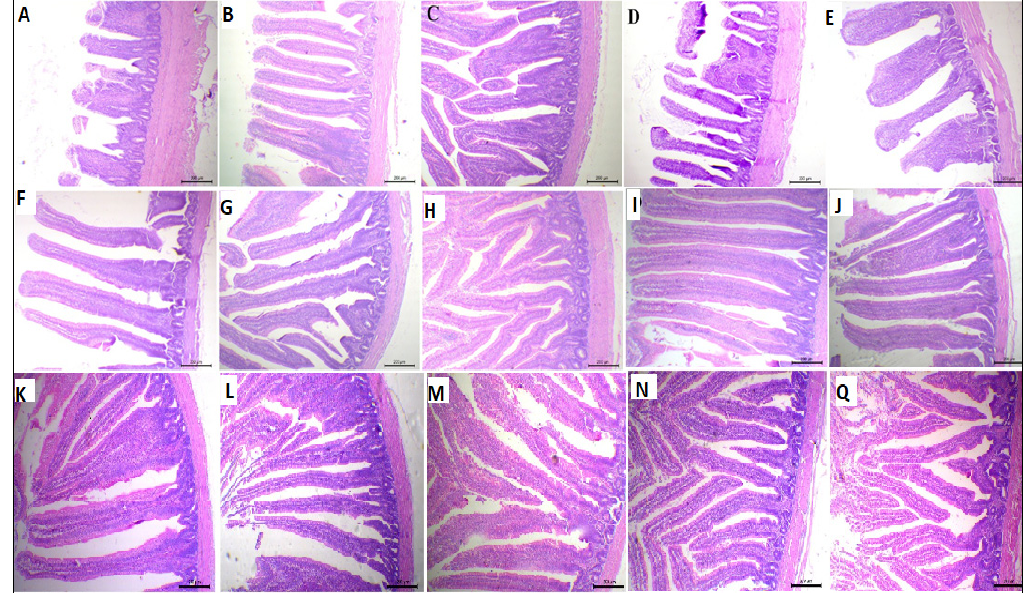
Figure 2. Photomicrograph of the small intestine: duodenum ( A – E ), jejunum ( F – J ), and ilium ( K – Q ) stained with hematoxylin and eosin stain; ARRE0 ( A , F , K ), ARRE50 ( B , G , L ), ARRE100 ( C , H , M ), ARRE200 ( D , I , N ), ARRE400 ( E , J , Q ).